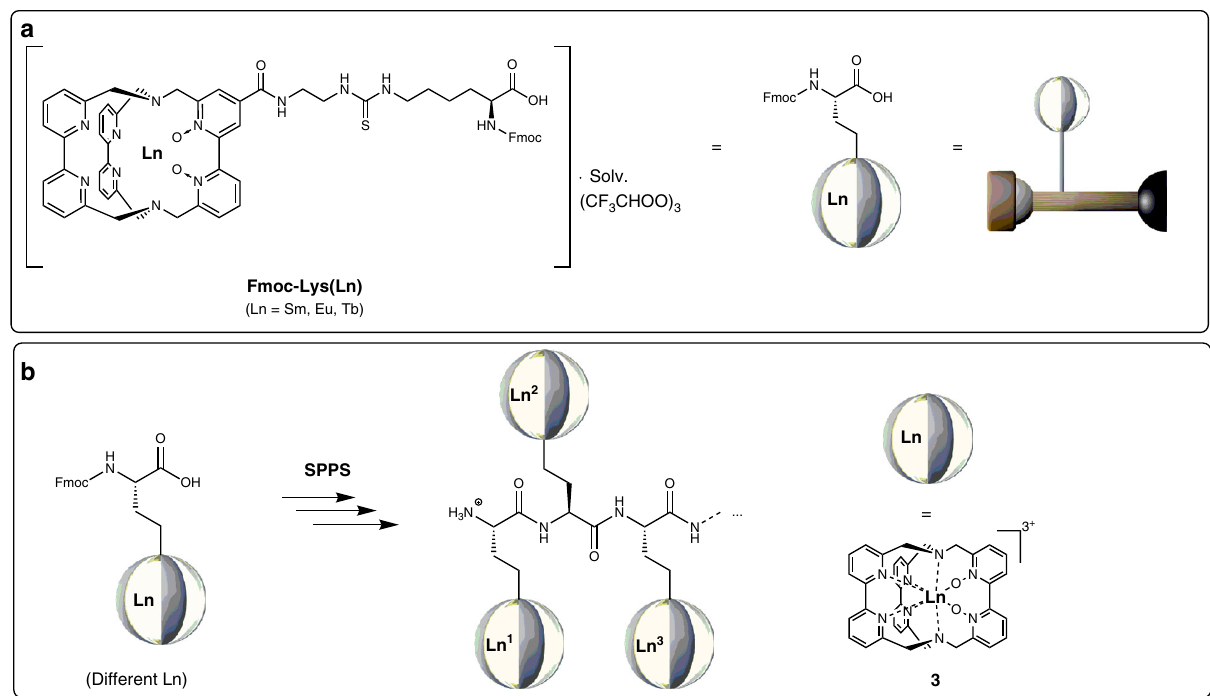
Fig. 3 Monomeric building blocks and their solid-phase peptide synthesis (SPPS) connection. a Structure of the lanthanoid building blocks Fmoc-Lys (Ln) . b SPPS of different monomeric Fmoc-Lys(Ln) yielding sequence-speci fi c, heterooligonuclear lanthanoid complexes.